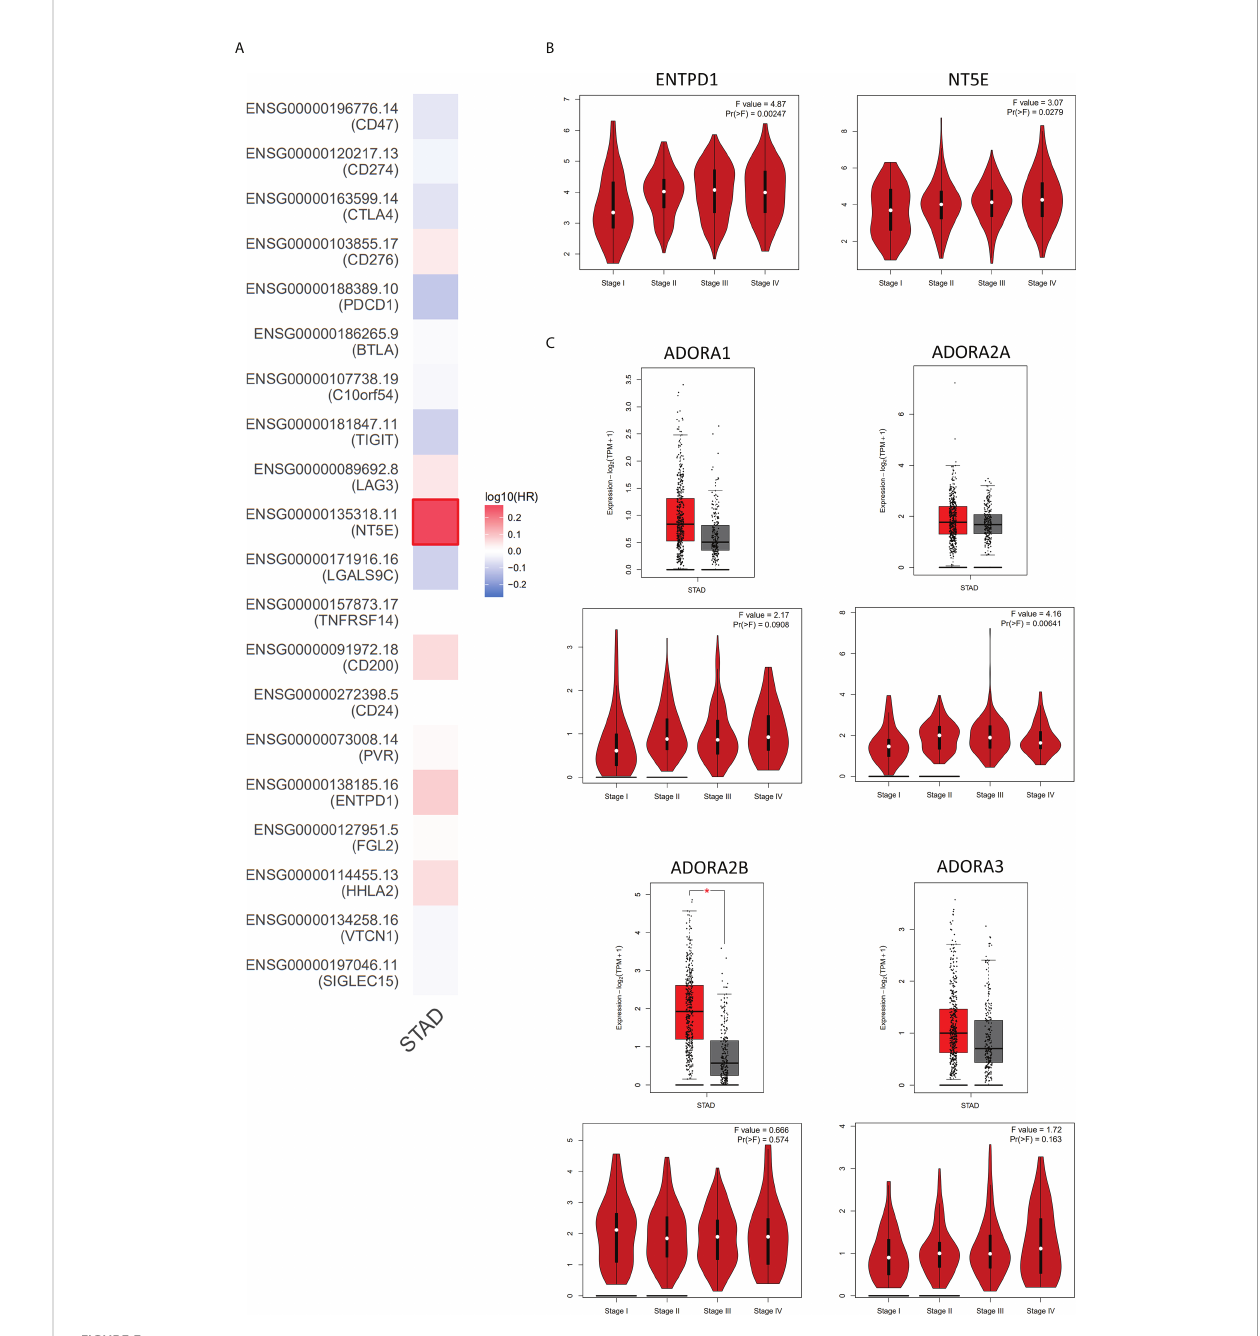
FIGURE 3 The analysis of adenosinergic pathway-related genes expression in GC by GEPIA database. (A) The risk assessment of 20 common immune checkpoint-related genes affecting the prognosis of GC patients. By comparing the survival contribution of multiple genes via Mantel-Cox test, we found that NT5E (encode CD73) showed the most obvious detrimental role in GC patients (n=383). (B) The expression levels of ENTPD1 and NT5E in different tumor stages of GC. With the progression of GC, the expression of ENTPD1 and NT5E also increased. (C) The expression levels of adenosine receptors in GC patients. The analysis showed that only ADORA2B expression (encode A2BR) increased in GC compared to the normal tissues and only ADORA2A (encode A2AR) was positively correlated with the progression of GC. Red color represents tumor tissue (n=408), and gray color represents normal tissue (n=211). STAD, stomach adenocarcinoma; HR, hazard ratio. * P <